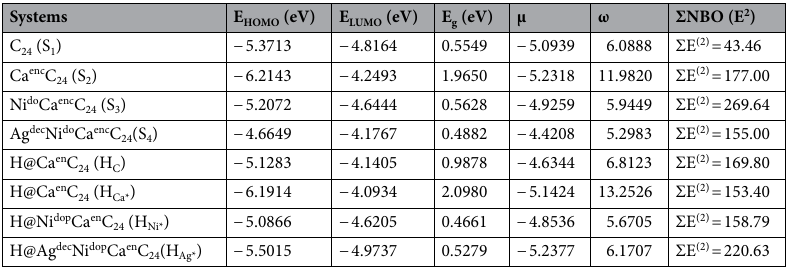
Table 1. The energies of the HOMO (eV), LUMO (eV), energy gap (E g ) and electronic NBO stabilization energies of the studied systems.